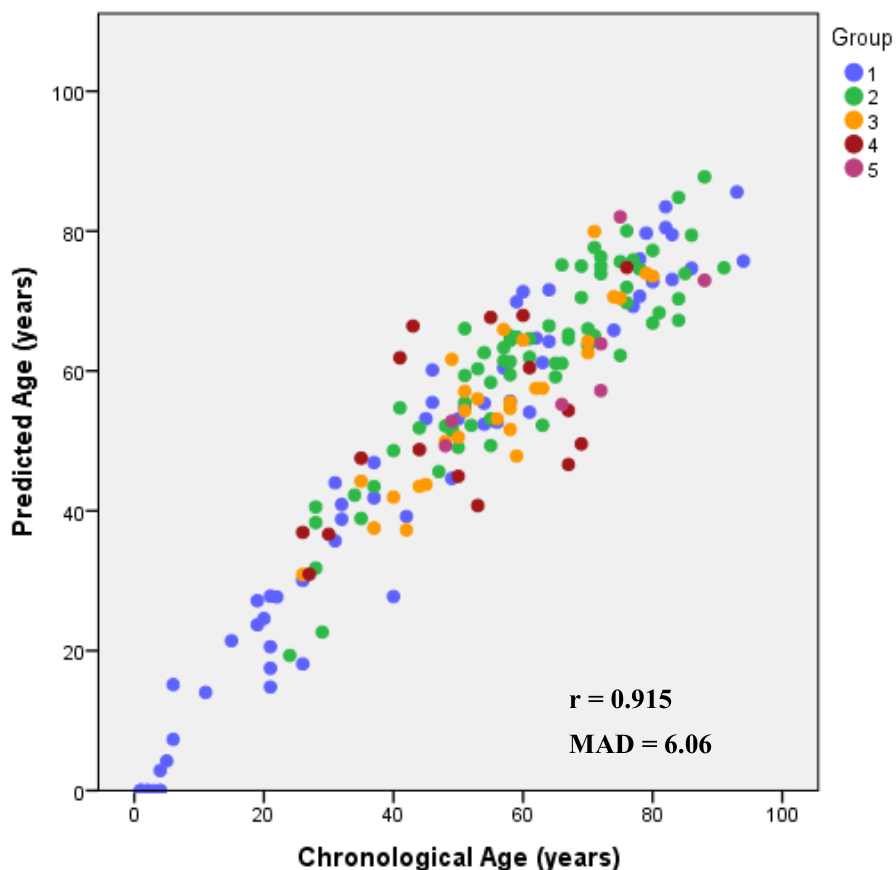
Figure 1. Predicted age versus chronological age using the multi-locus multi-tissue APM developed for ELOVL2 , FHL2 , EDARADD , PDE4C and C1orf132 genes including blood samples from living individuals (1), blood samples from deceased individuals (2), bone samples (3), tooth samples from living individuals (4) and tooth samples from deceased individuals (5). The corresponding Spearman correlation coefficients (r) are depicted inside each plot.